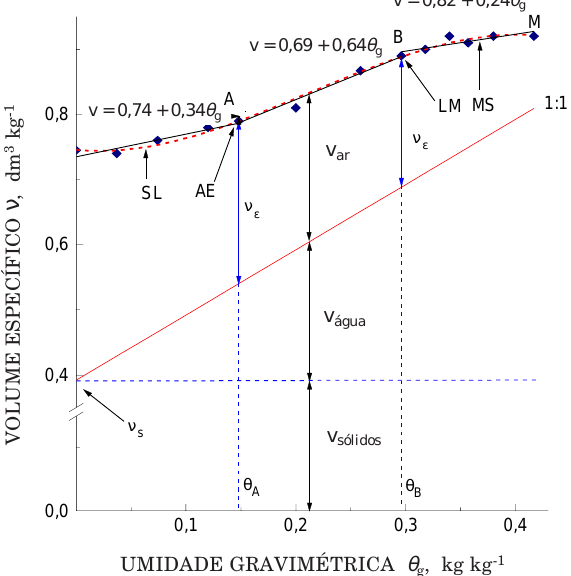
Figura 4. Variação do volume das amostras (V do solo em função da umidade obtida das tomografias ( qqqqq